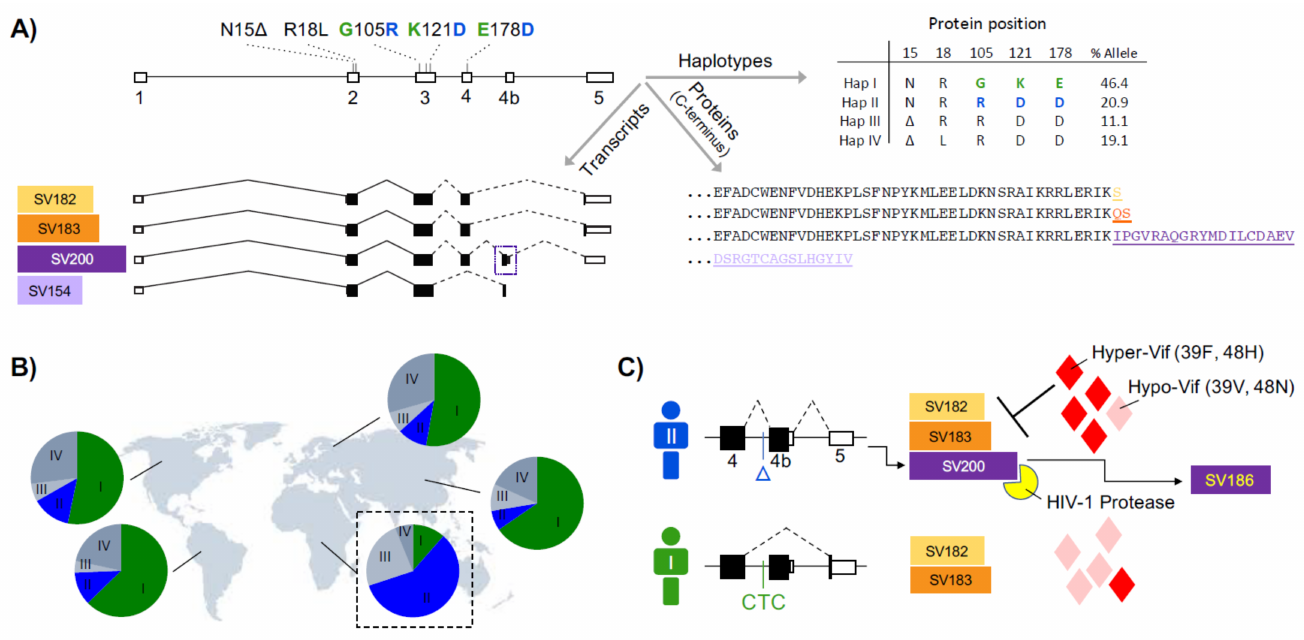
Figure 3. APOBEC3H variations. ( A ) Main APOBEC3H haplotypes, splice variants, and protein variants; ( B ) geographic distribution of main APOBEC3H haplotypes; ( C ) a schematic of population-specific APOBEC3H mRNA splicing, HIV-1 protease processing of SV200 into SV186, and adaptation of HIV-1 Vif to